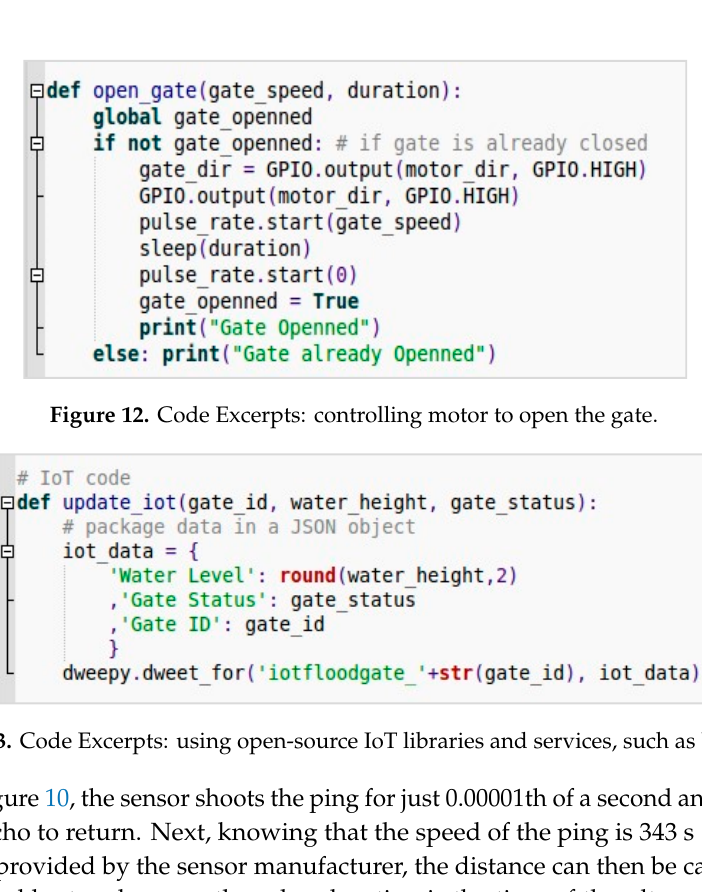
Figure 13. Code Excerpts: using open-source IoT libraries and services, such as Dweet.io.